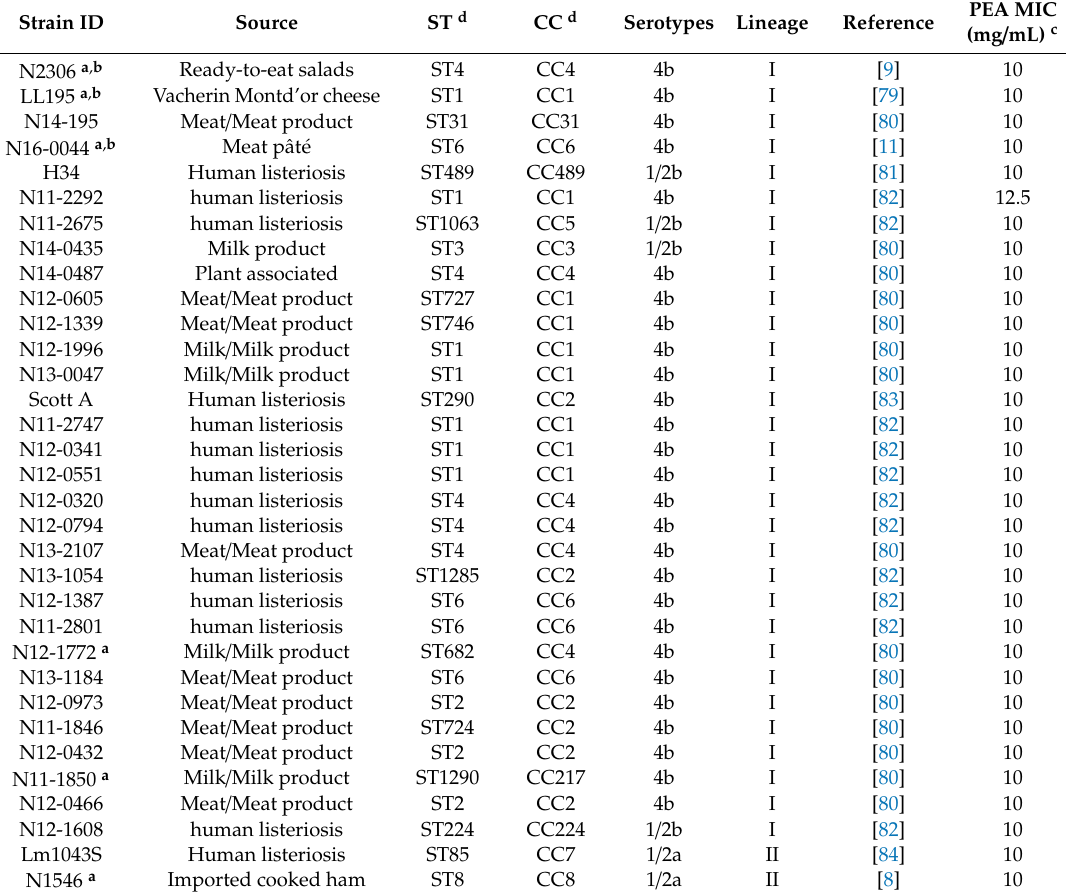
Table 1. Study strains and their PEA MIC in di ff erent